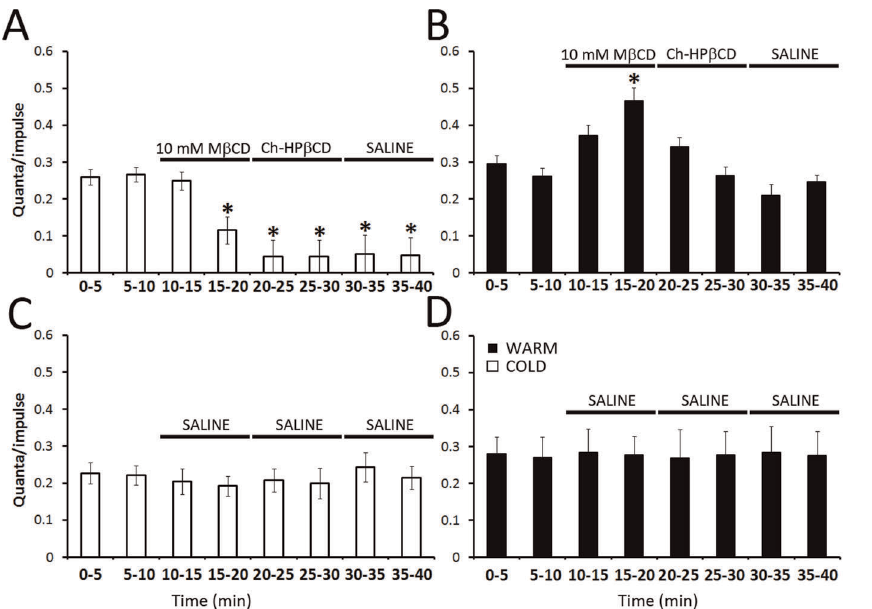
Figure 3. M b CD has opposing effects on quantal content in neuromuscular preparations from cold- vs. warm-acclimatized animals. Extracellular focal recordings were made from nerve branches within abdominal segment IV while stimulating the nerve in segment III. These recordings detected the presynaptic current and postsynaptic response following nerve stimulation. Quantal content was determined using the failures method. A . Cold-acclimatized group (open bars). First 10 min reflects saline perfusion. Application of 10 mM M b CD ultimately resulted in a significant reduction of quantal content after 10 min; this correlated with a reduction in EJP amplitude, and a loss of the nerve terminal signal. Quantal content could not be recovered with cholesterol loading (10 mM Ch-HP b CD) or a subsequent saline wash B . Warm-acclimatized group (closed bars). Application of 10 mM M b CD ultimately resulted in a significant increase in quantal content after 10 min. The increase in quantal content reversed following the application of 10 mM Ch-HP b CD, and stabilized to control levels during the saline wash. C–D . Control recordings from the cold- and warm-acclimatized groups, respectively, indicate stable quantal content over the 40 min recording period. (Stimulation: 0.2 Hz, data were averaged into 5 min bins, giving 60 stimuli per bin. N=7. * indicates P , 0.05.).